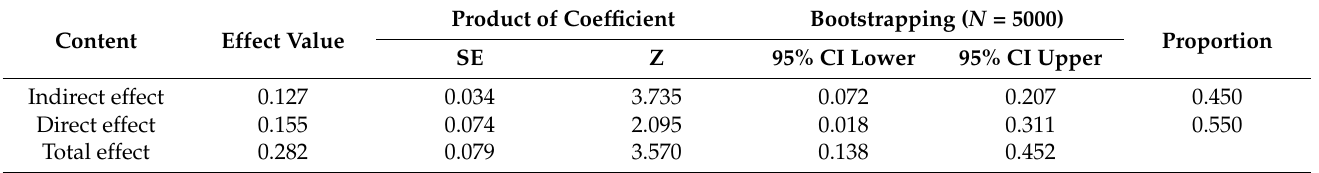
Table 14. Results of the mediation